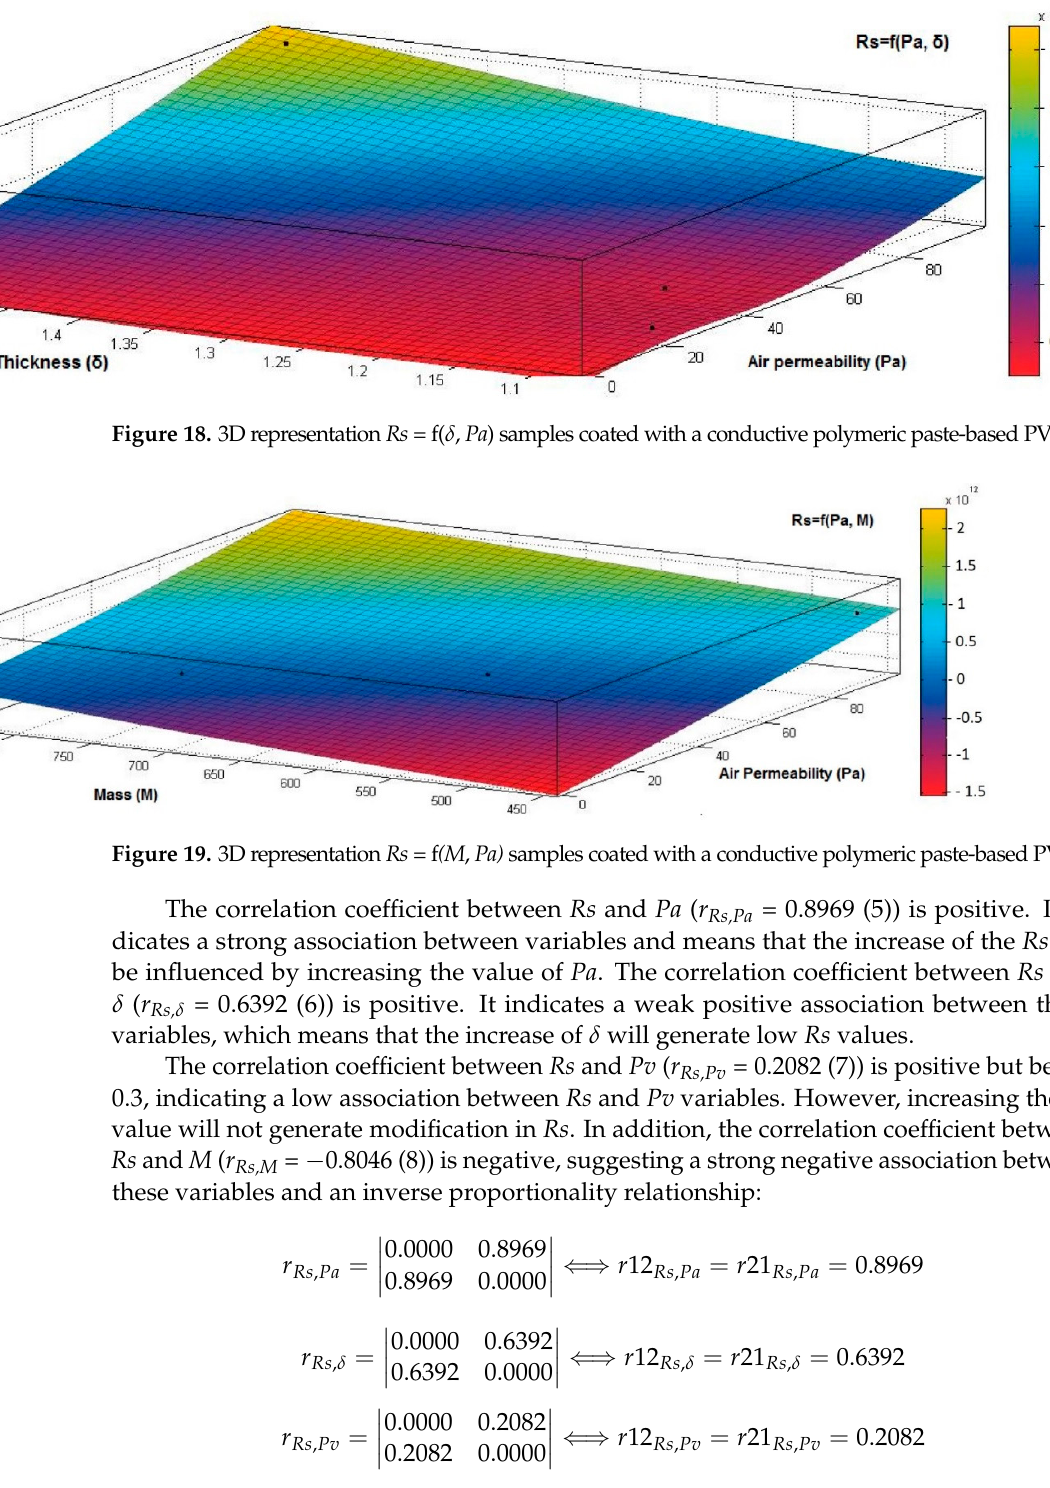
Figure 17. 3D representation Rs = f( δ , Pv ) samples coated with a conductive polymeric paste ‐ based PVDF.